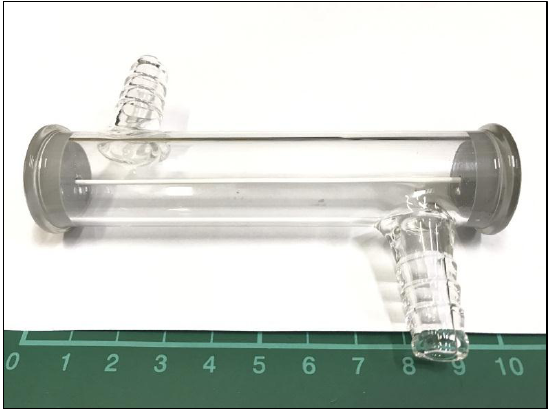
Figure 1. Hydrophobic aluminum hollow fiber module.